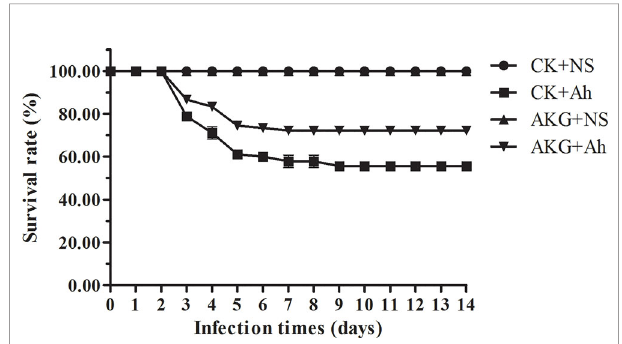
FIGURE 1 | Effects of AKG on survival rate of A. hydrophila infected-Songpu mirror carp. Survival data was registered for uninfected Songpu mirror carp ( Cyprinus carpio ) fed with or without AKG supplementation as well as A. hydrophila -challenged Songpu mirror carp fed with or without AKG supplementation. The number of carp was 30 per